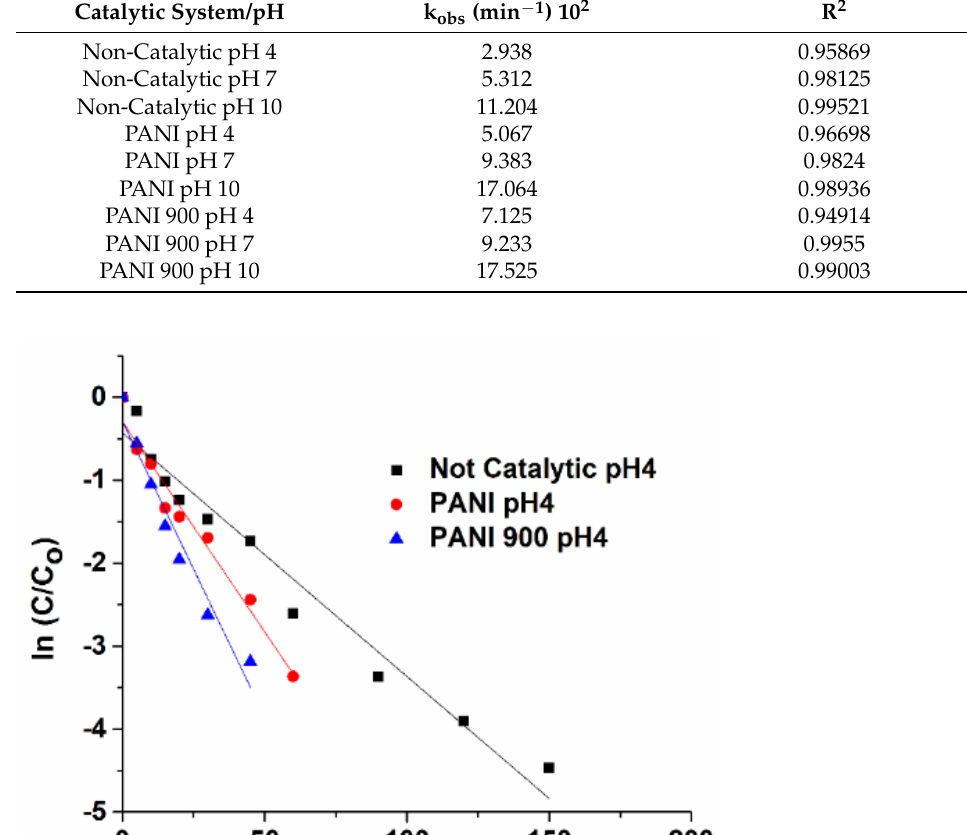
Table 4. Kinetic parameters for the ibuprofen oxidation for different pH values.